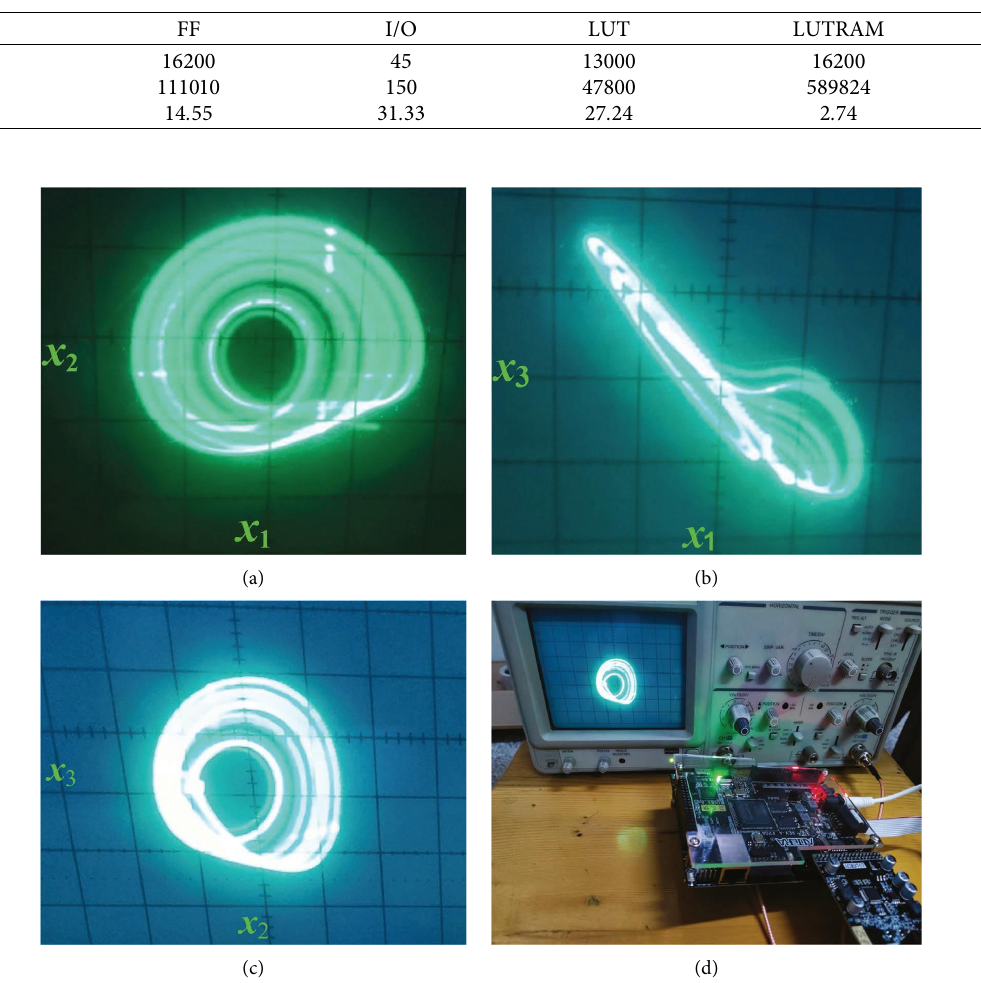
Table 1: Te resource utilization of the chip.